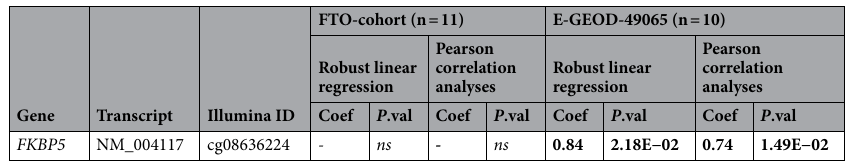
Table 3. Methylation/transcription correlations of FKBP5 associated CpG site cg08636224 which is negatively correlated with baseline cortisol levels. The table lists CpG-sites located within the TSS2000 of HPA-axis genes with significant cortisol post DST-associated methylation changes. These methylation probes are investigated for a correlation with transcription in two separate cohorts with healthy controls (FTO-cohort and E-GEOD-49065 cohort). Methylation M-values were correlated with expression values inter-individually, by pearson correlations and robust linear regression models, respectively. Coef . regression coefficient; P .val, P